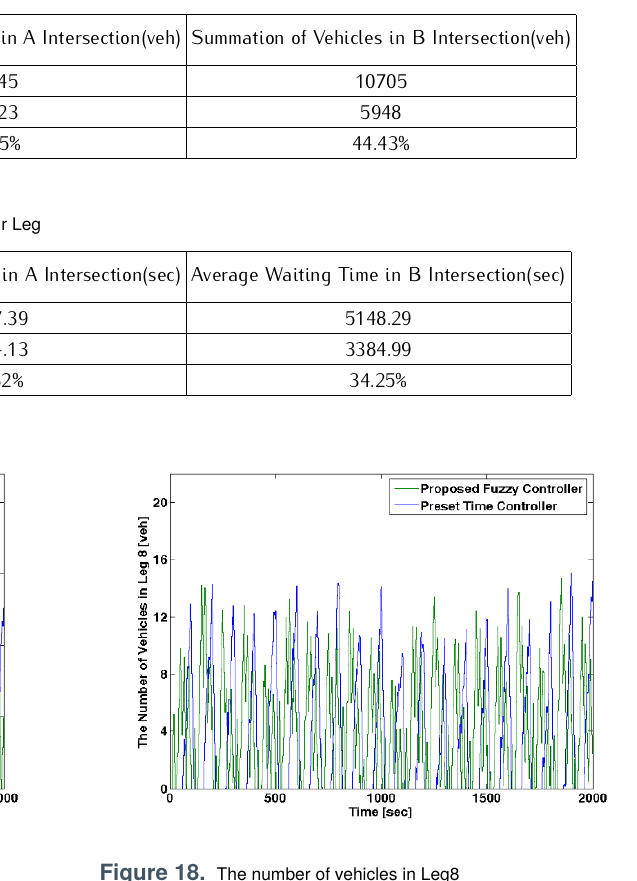
Figure 17. The number of vehicles in Leg7 Figure 18. The number of vehicles in